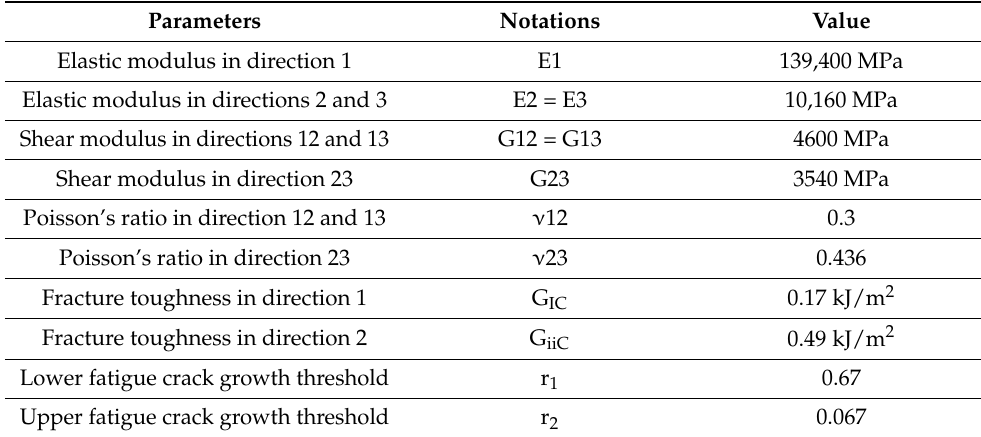
Table 1. Material properties and fatigue parameters of T300/1076 graphite